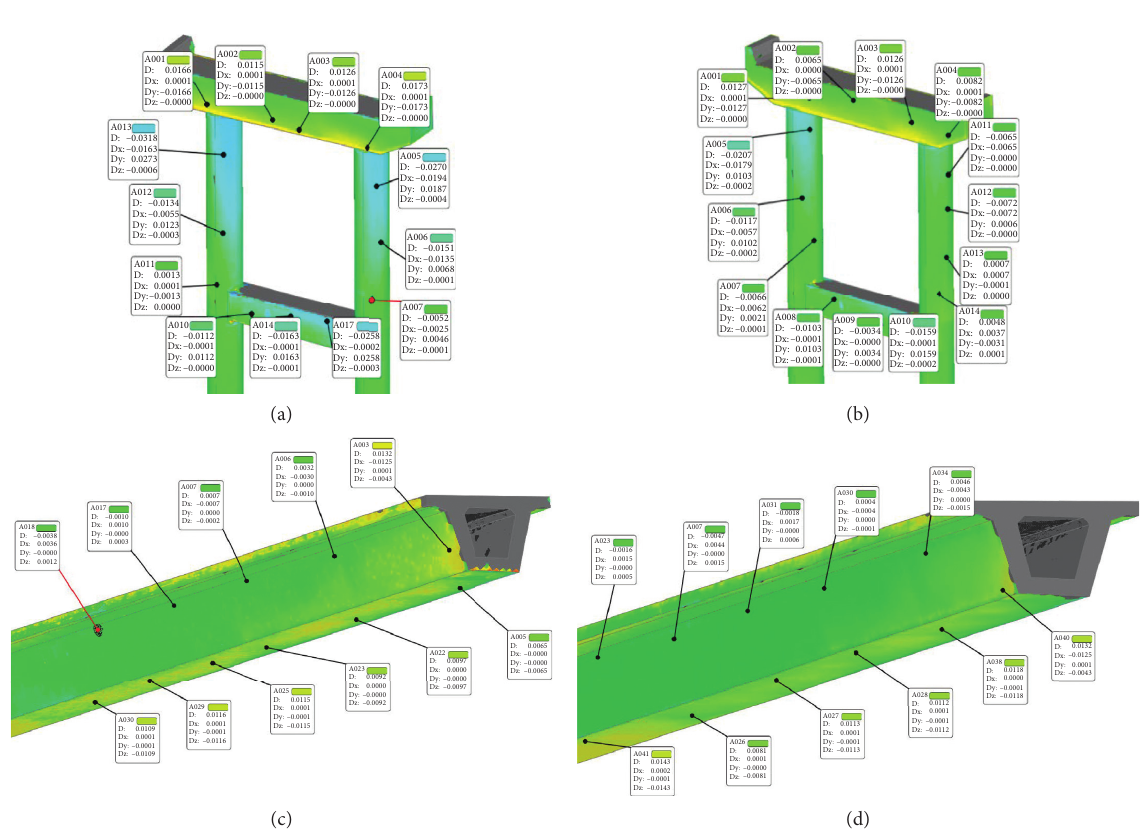
Figure 23: (a, b) 3D comparison of the pier column; (c, d) 3D comparison of the precast box girder